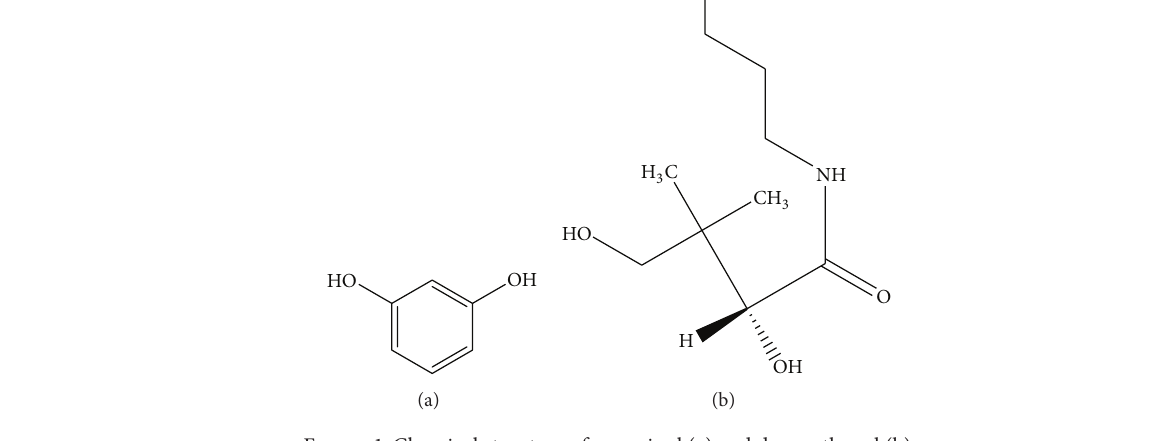
Figure 1: Chemical structure of resorcinol (a) and dexpanthenol (b).